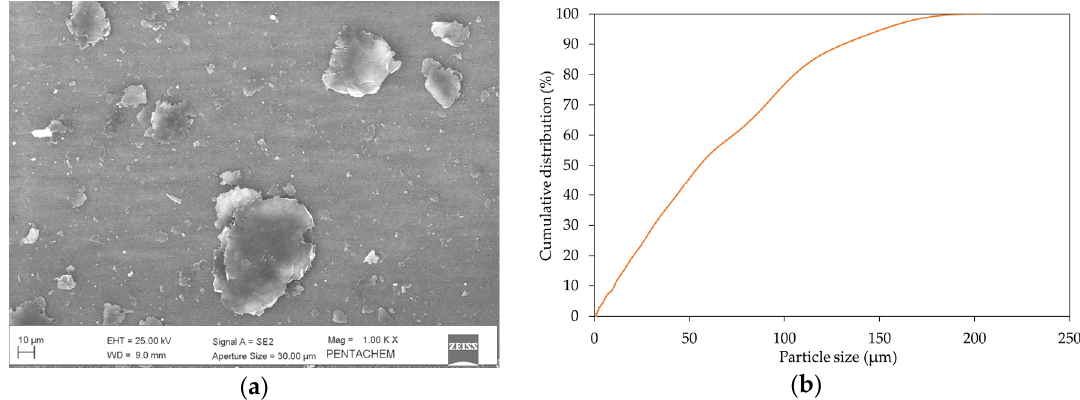
Figure 1. ( a ) SEM image and ( b ) particle size distribution of graphene nanoplatelets (GNP).